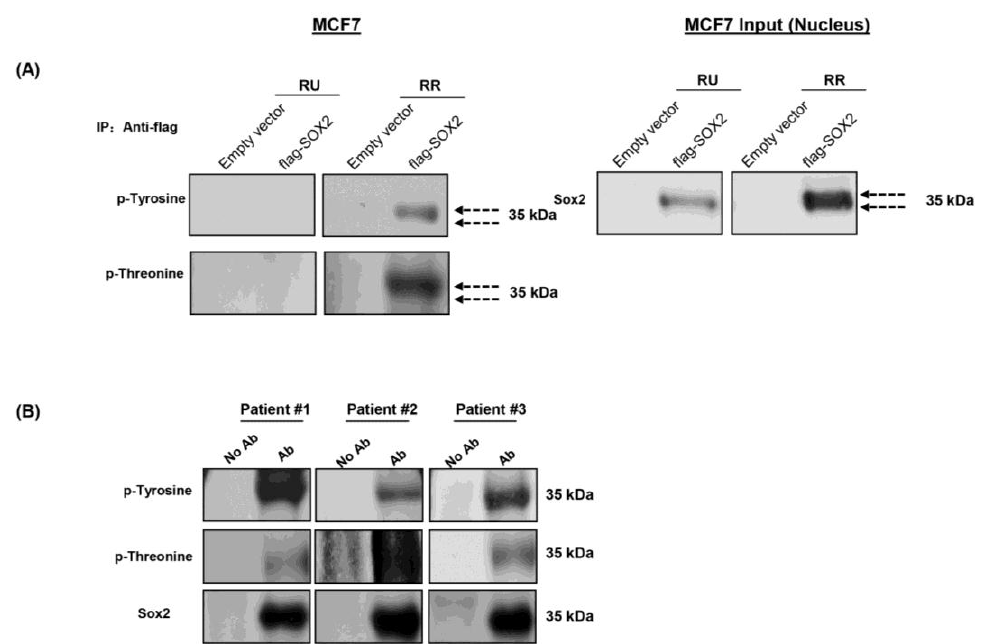
Figure 2. RR cells had higher phosphorylation of Sox2. Immunoprecipitation experiments were carried out using RU and RR cells derived from MCF7 cells transfected with flag- SOX2 . Precipitation was carried out using the anti-flag M2 affinity gel and Western blot was carried out using Sox2, p-Tyrosine and p-Threonine antibodies. ( A ) Right panel represents immunoprecipitation of flag-Sox2 pulled down in both RU and RR cells derived from MCF7 cells. Of note, two bands of Sox2 were identified in RR cells whereas only one band was identified in RU cells. Left panel represents Western blots results probed with anti-phospho-tyrosine (p-tyrosine) and anti-phospho-threonine (p-threonine) revealed evidence of Sox2 phosphorylation in RR but not RU cells; ( B ) Western blot of Sox2 was performed using 3 patient tumor samples. Immuno-reactivity with anti- p -tyrosine and anti- p -threonine was detected in all 3 samples.